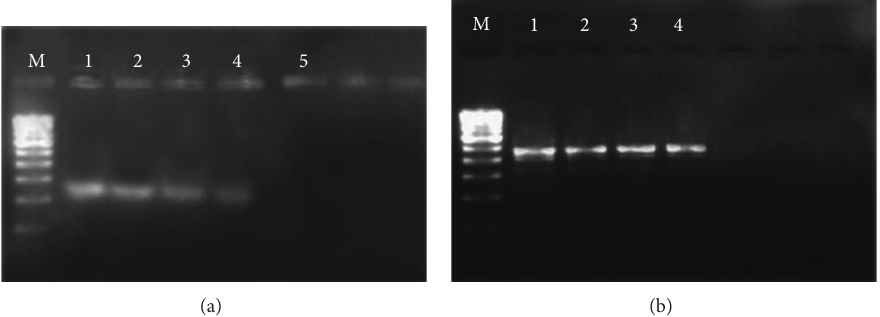
Figure 4: (a) Downregulation of MMP-9 was assessed after 24 h treatment with various concentrations of OSEO in LPS-induced cells. Denotation for lanes: M (100–1000 kb ladder marker), 1 (50 𝜇 g/mL), 2 (100 𝜇 g/mL), 3 (150 𝜇 g/mL), 4 (200 𝜇 g/mL), and 5 (250 𝜇 g/mL) of OSEO. (b) 𝛽 -Actin (452 bp) served as an internal